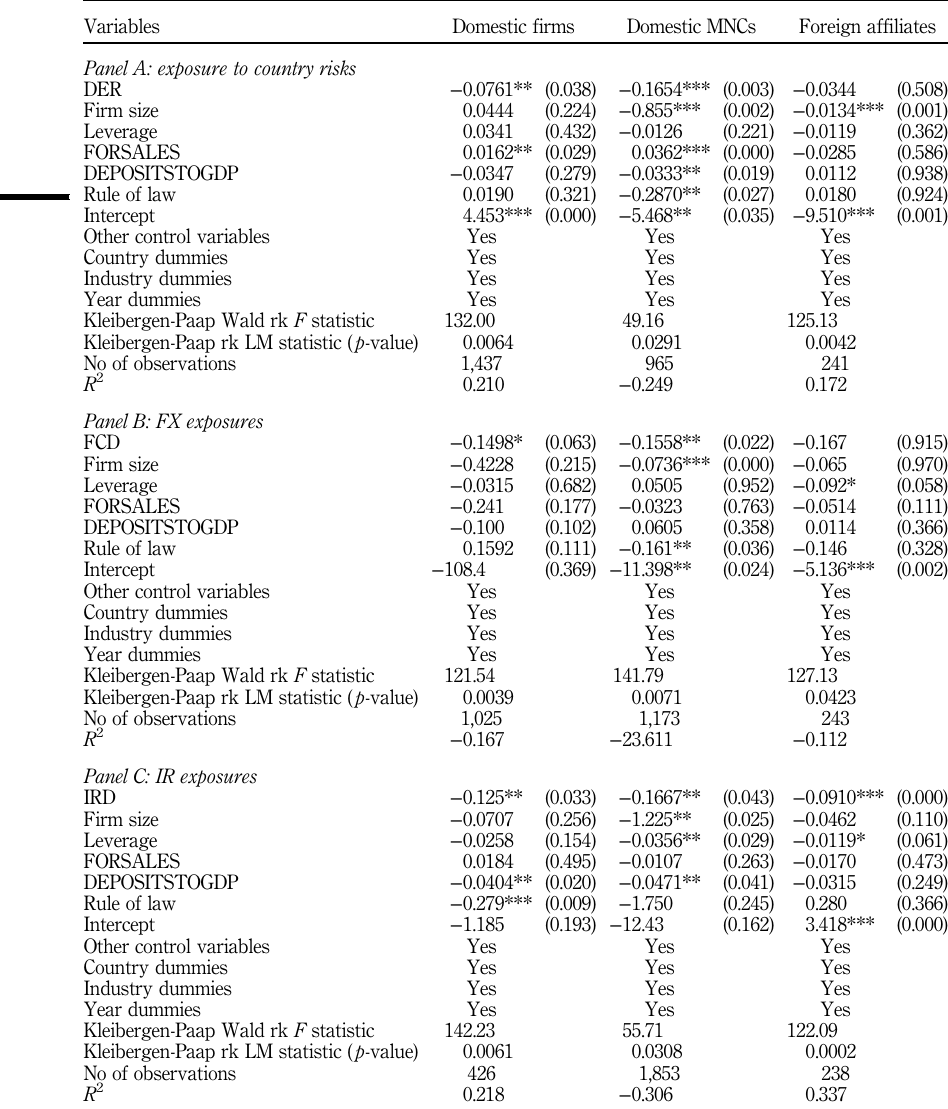
Table VI. Instrumental